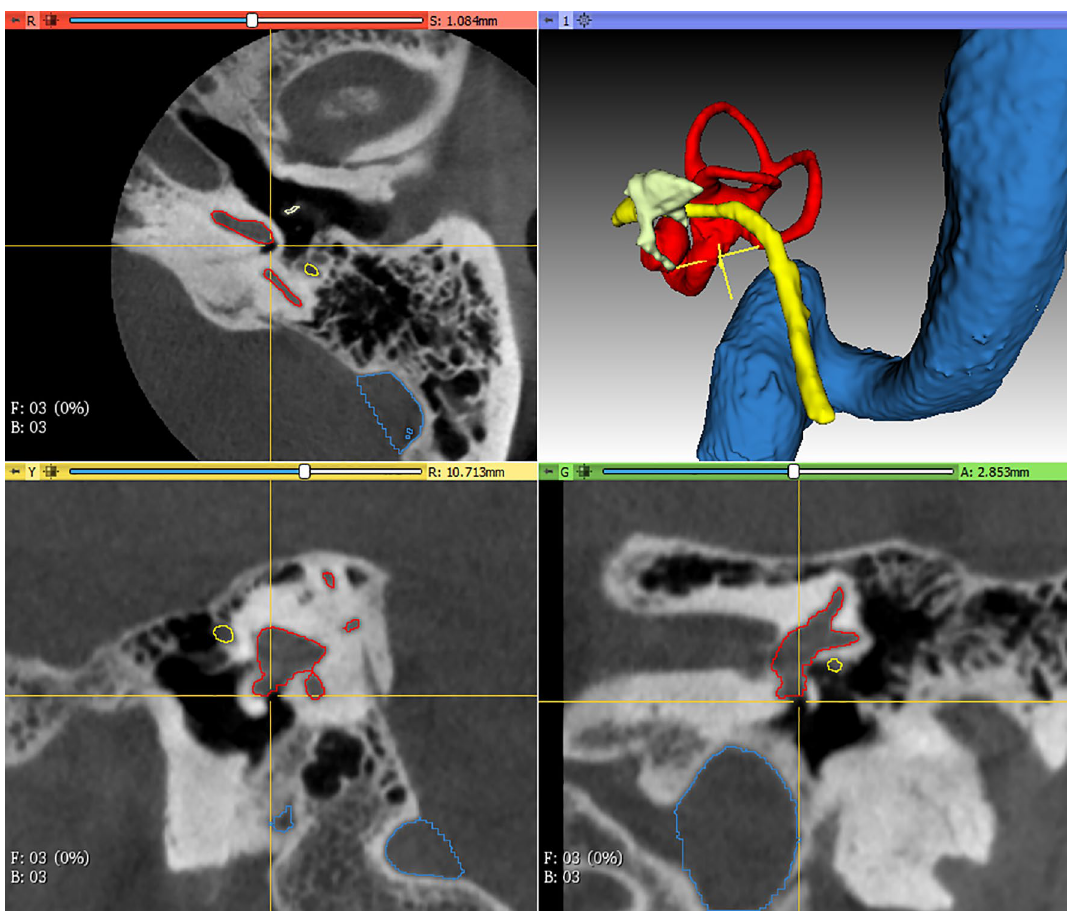
Figure 1. Manual segmentation of temporal bone structures as seen in 3D Slicer: inner ear (red), ossicles (ivory); facial nerve (yellow), sigmoid sinus (blue). Crosshair is centered over the round window